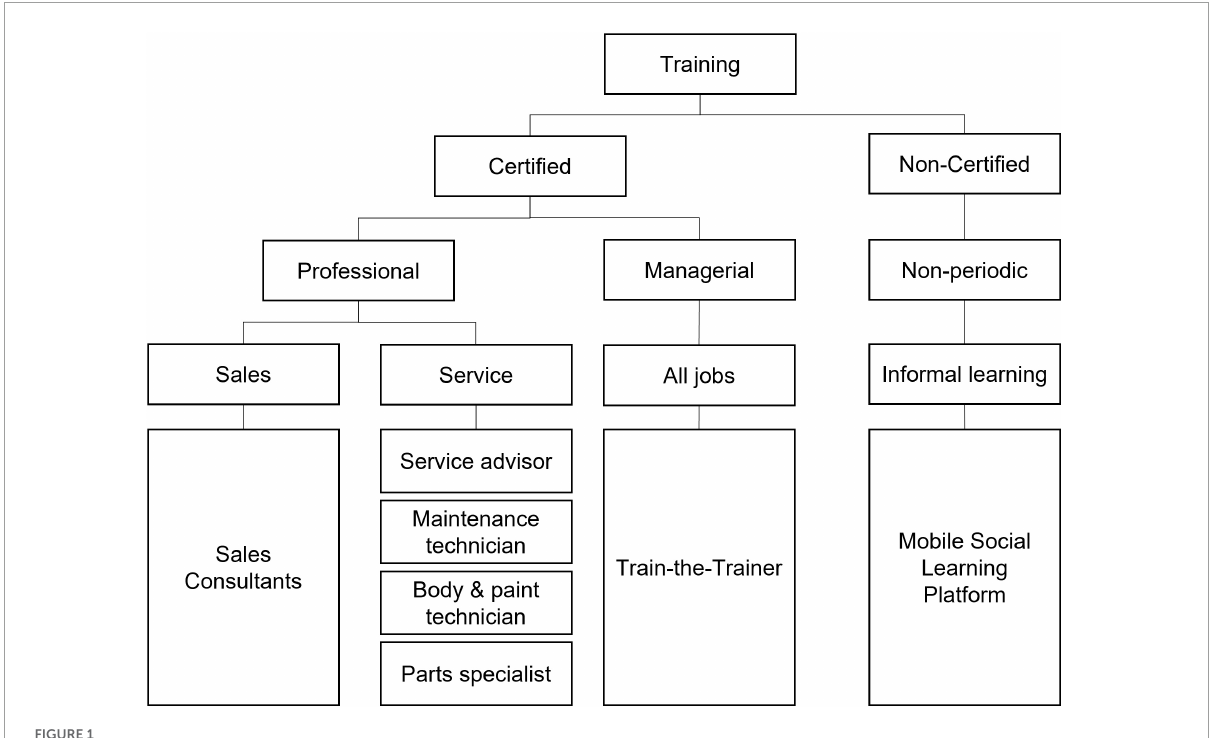
FIGURE1 Human resource development at Company